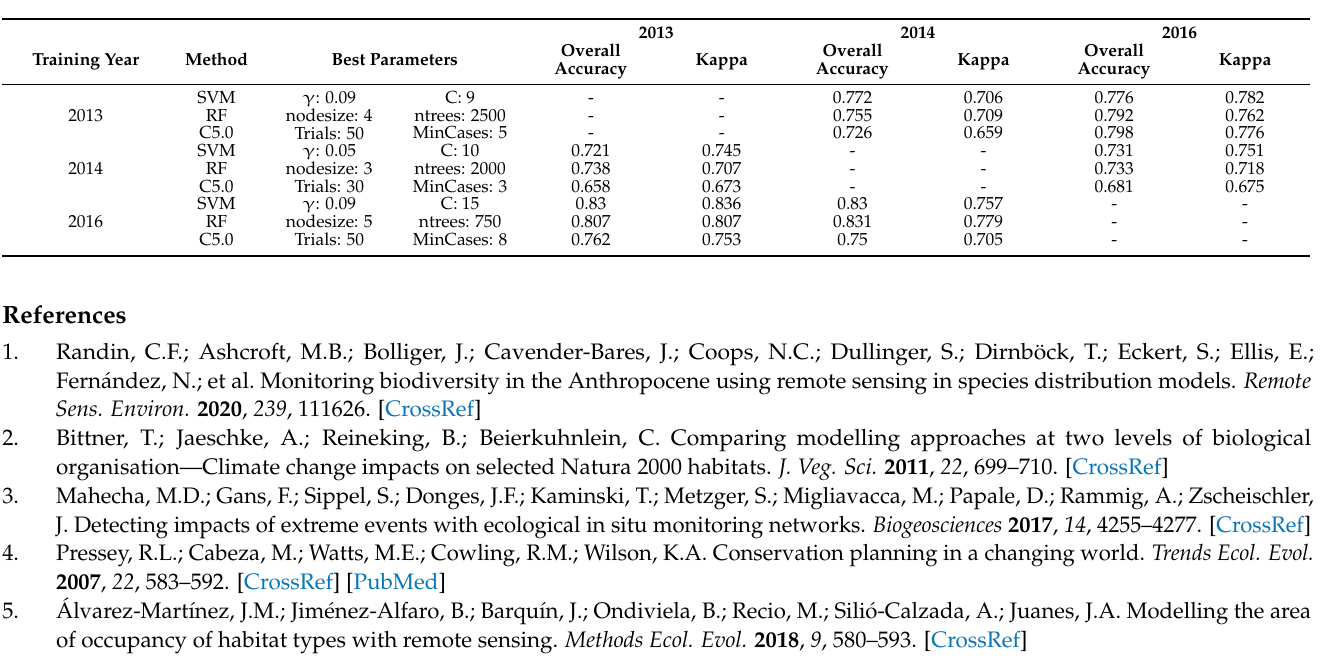
Table A5. Model performance measures when the models are validated against the pixels of the other training